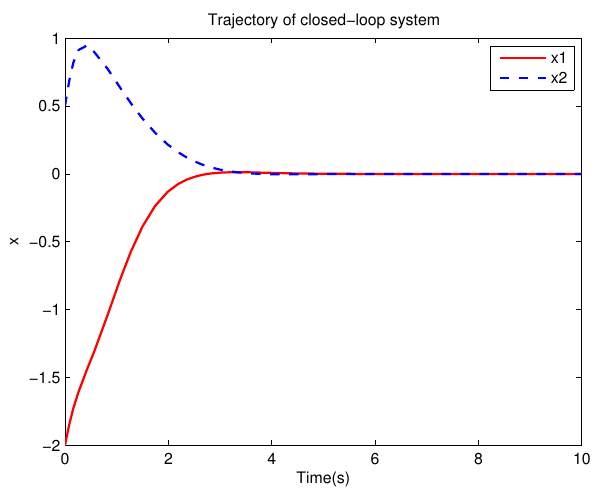
Figure 9. Closed loop system trajectory, p 1 = − 1, p 2 = 2, p 3 =